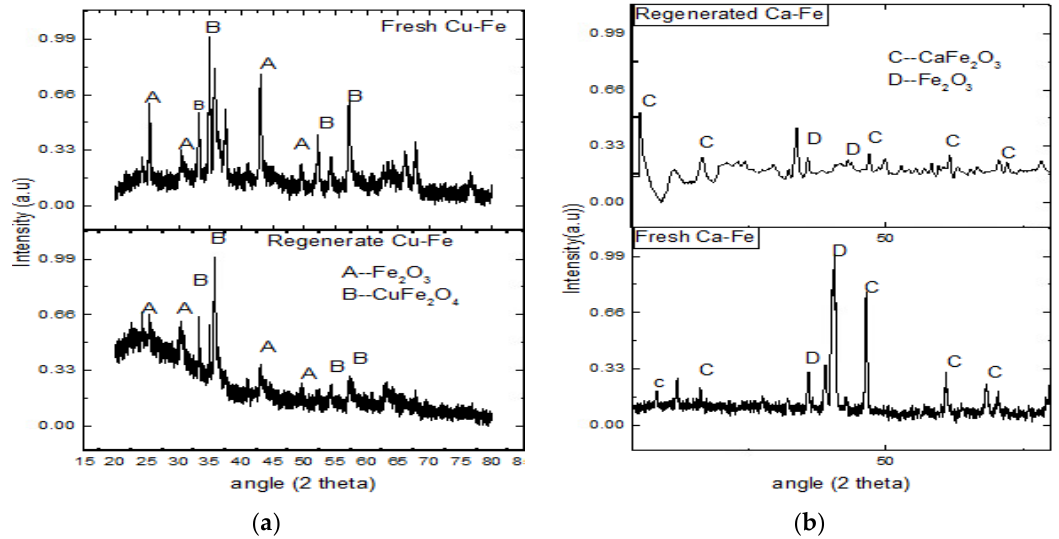
Figure 4. XRD patterns of fresh and regenerated oxygen carriers; ( a ) Fe-Cu oxide and ( b ) Fe-Ca